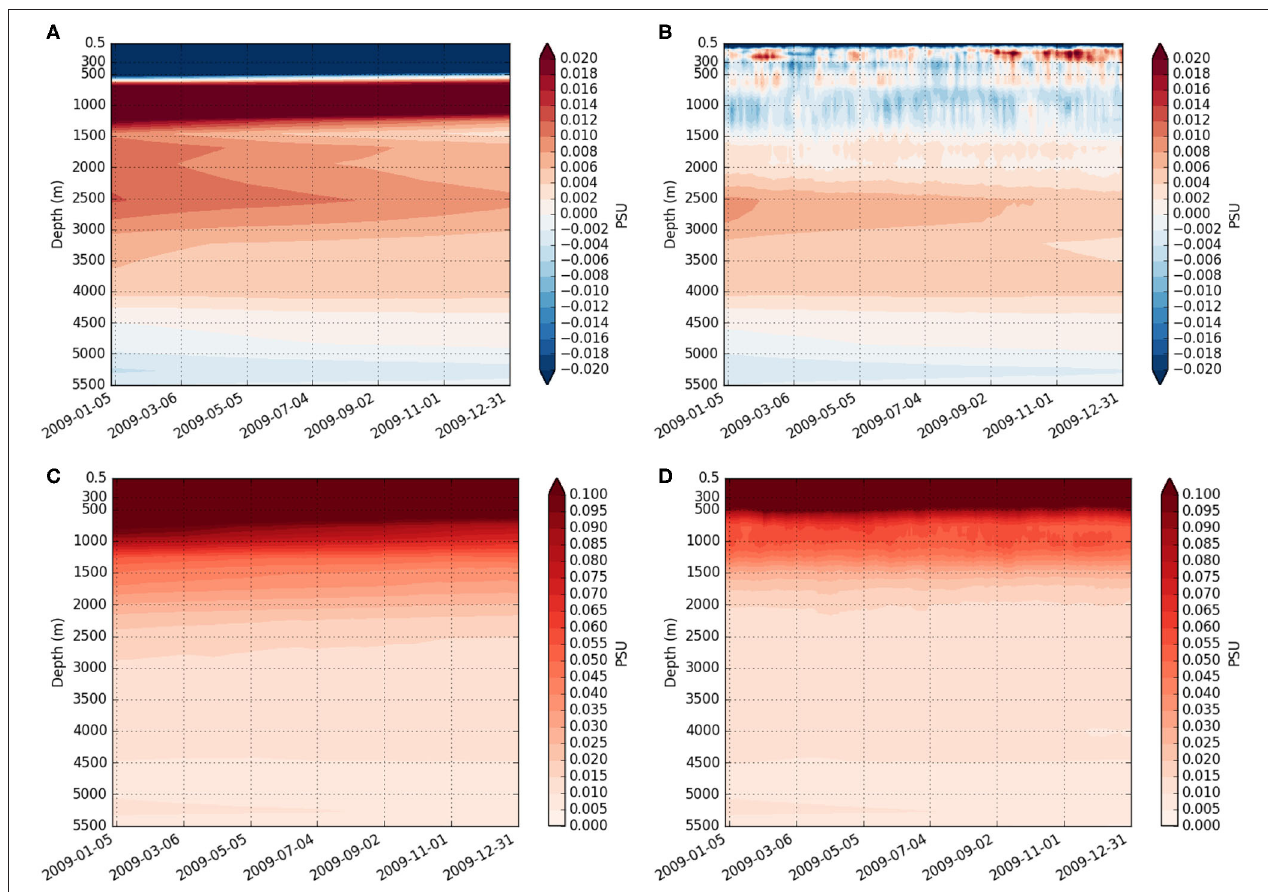
FIGURE 4 | Hovmöller plots of OSSEs-NR statistics for salinity field in the Atlantic over January–December 2009: (A) Free Run bias, (B) Backbone bias, (C) Free Run RMSE, and (D) Backbone